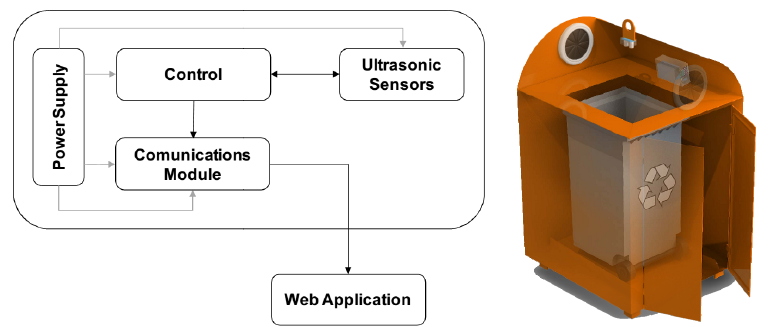
Fig. 5. System architecture (left) and container with the level monitoring system